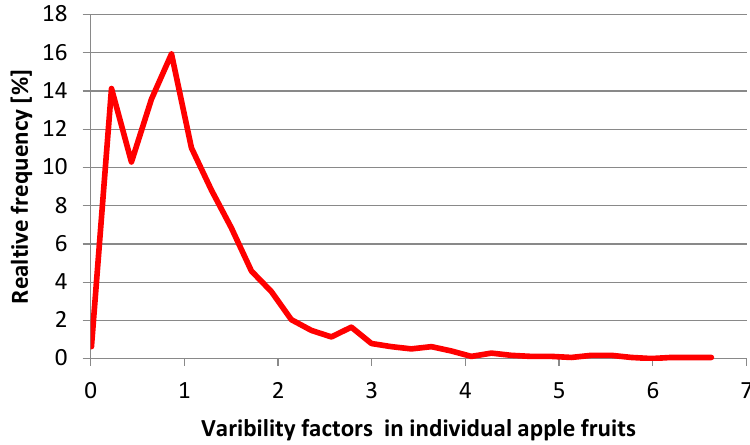
Figure 5. Variability factors (1769) for captan residues in individual apples.